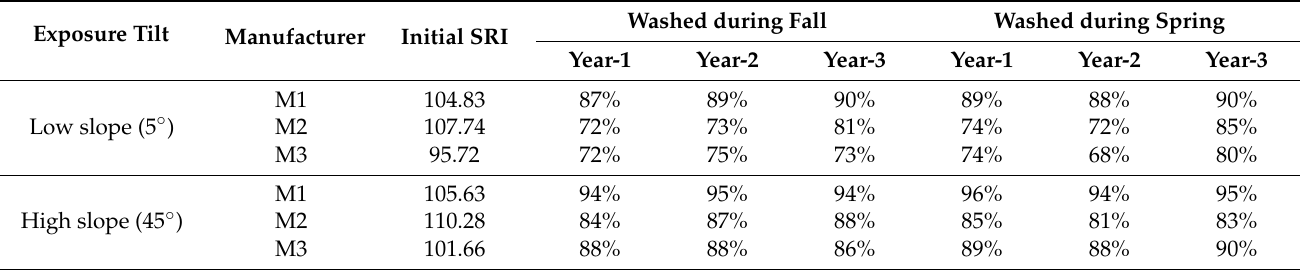
Table 3. Retention of initial SRI values through annual maintenance (fall and